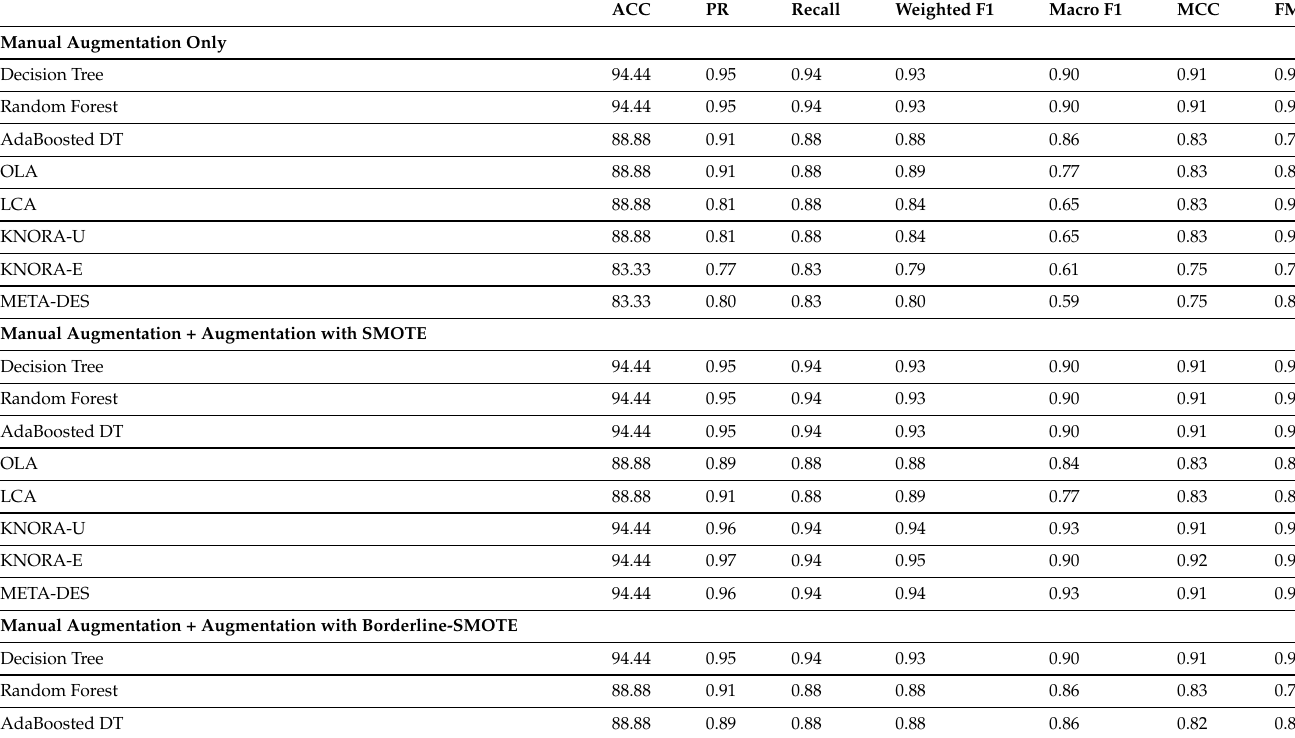
Table 4. Results for the hold-out method for the ensemble models implemented based on the framework proposed by Pineda-Bautista et al. [23].